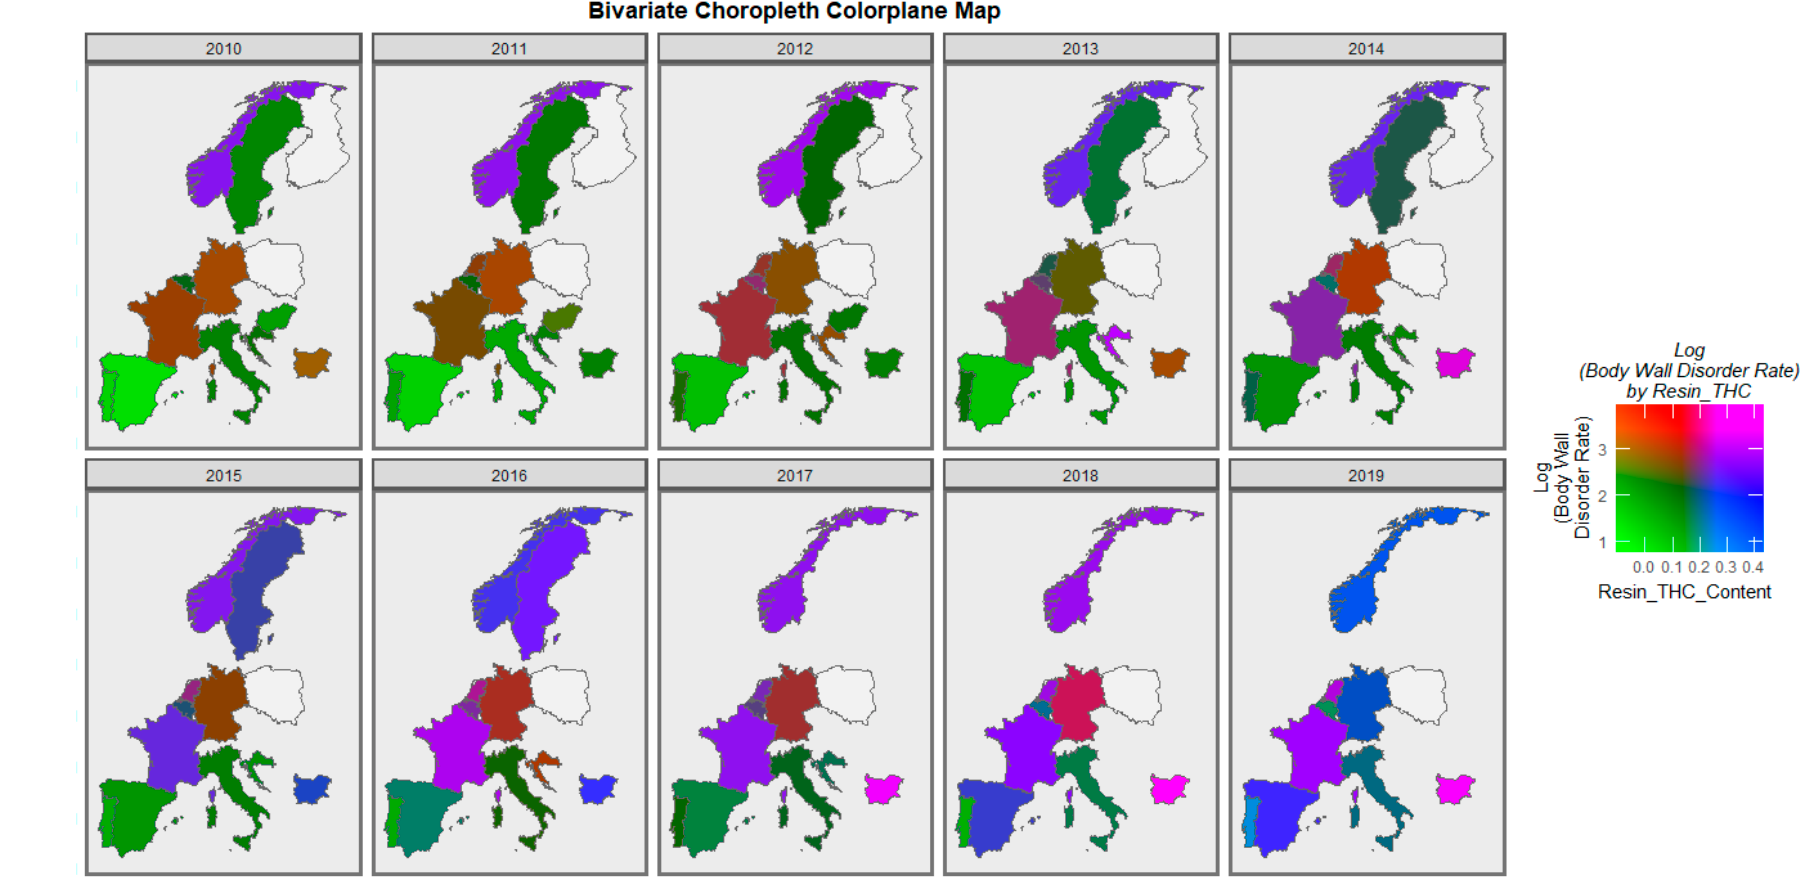
Figure 8. Bivariate colorplaner sequential map-graph of body wall anomalies by cannabis resin THC concentration across selected European nations for each year of 2010–2019. For explanation, please see text.